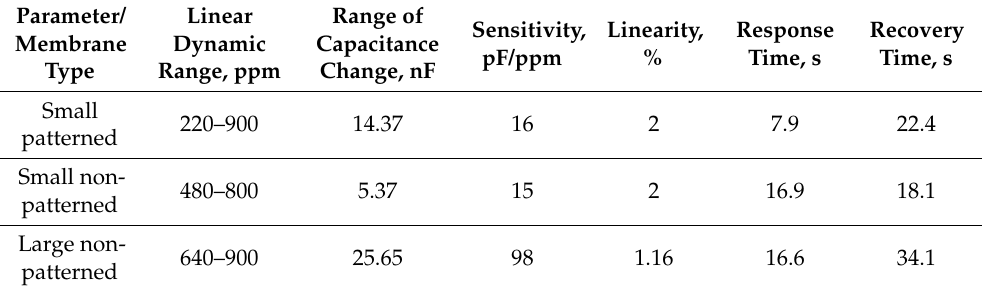
Table 1. Main ethanol detection parameters of the capacitive devices with different membrane sizes and patterns, using carbyne-enriched coating as a sensing